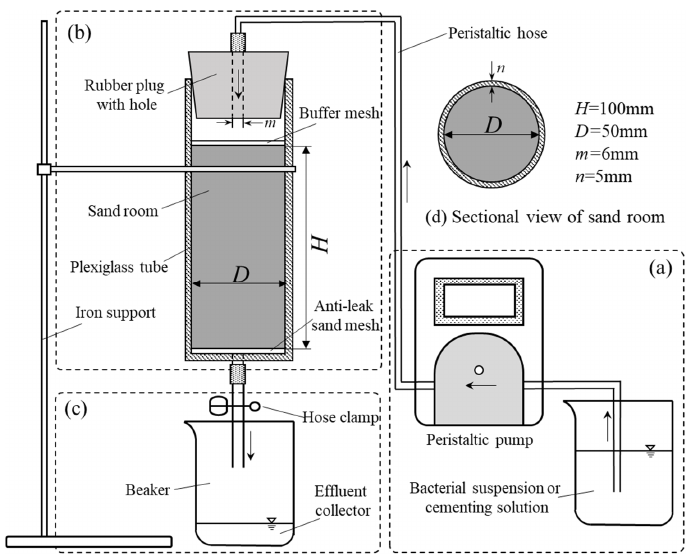
Figure 3. Schematic diagram of the microbially induced calcite precipitation (MICP) experimental setup: ( a ) power system; ( b ) cementitious system; ( c ) drainage system; ( d ) sectional view of sand room.